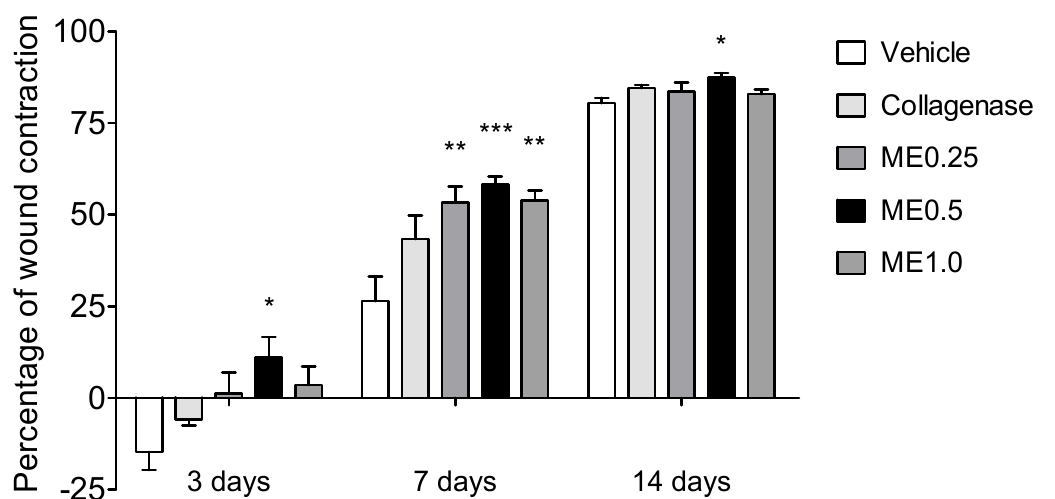
Figure 1. Percentage of skin wound contraction at the back of rats after 3, 7, or 14 days of treatment with vehicle, collagenase cream, ME.025, ME0.5, or ME1.0. ANOVA, Dunnett’s test; * p < 0.05, ** p < 0.01, *** p < 0.001.